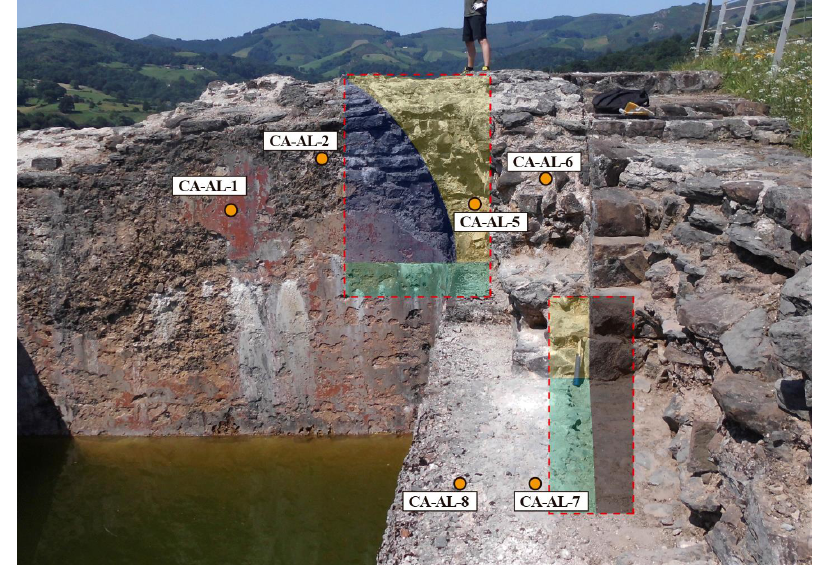
Figure 2. Location of the studied samples within the cistern. Cistern tank in green, vault lunette in blue, barrel vault in yellow, and 14th – 15th centuries wall in black.